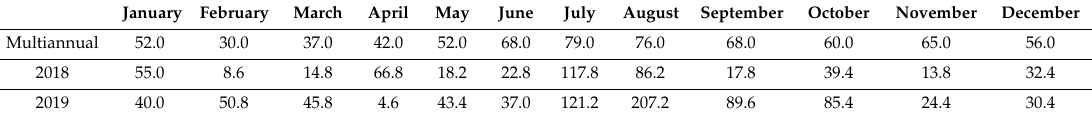
Table 3. Total monthly precipitation (mm) in 2018 and 2019 compared to multiannual (average of 100 years).